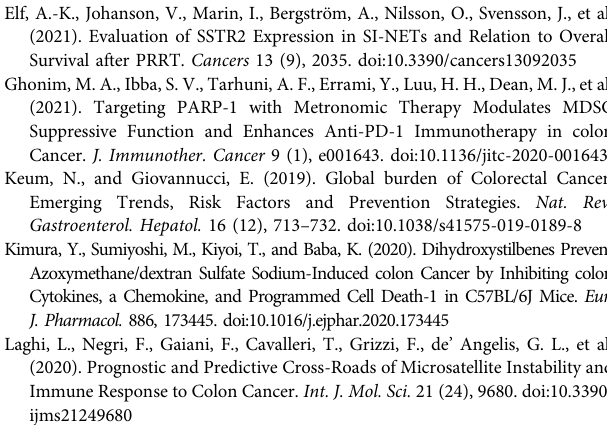
Supplementary Table S7 . Our constructed prognostic model was relatively and effectively validated in more internal and external cohorts, including an immunotherapeutic